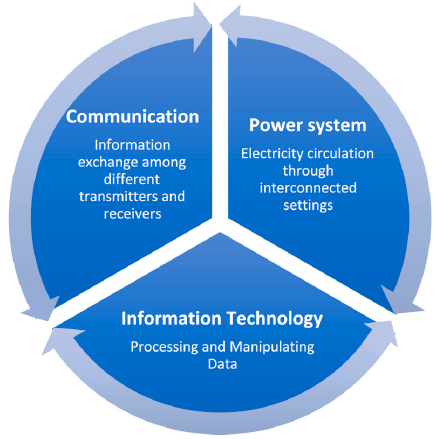
Figure 1. Smart grid architecture in compliance with IEEE 2030.